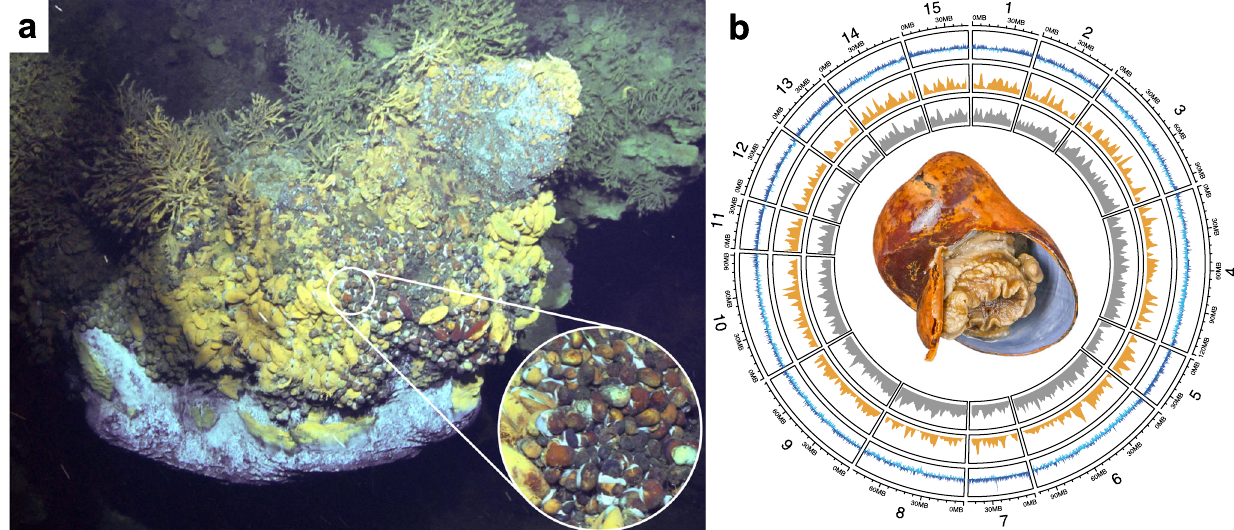
Fig. 1 The genome landscape of the snail Gigantopelta aegis living in Tiamat chimney. a Two chemosymbiotic peltospirid snails, Gigantopelta aegis and the Scaly-foot Snail Chrysomallon squamiferum , occurring in great abundance side-by-side at Tiamat chimney in the Longqi vent fi eld on the ultra-slow spreading Southwest Indian Ridge ( G. aegis in dark orange; C. squamiferum in black). b A circos plot shows key features of 15 pseudo-chromosomal linkage groups of the G. aegis genome showing an adult snail at the centre, the inner circle (grey) indicating the gene density of each pseudo-chromosome, the second circle (orange) indicating the gene density of highly expressed genes in the oesophageal gland ( n = 4), and the outer circle (blue) showing the GC content of the deviation from the average 37.22%. The outer bars show the chromosome length. A sliding window of 100 kb in a step of 50 kb was applied in the calculation of the GC